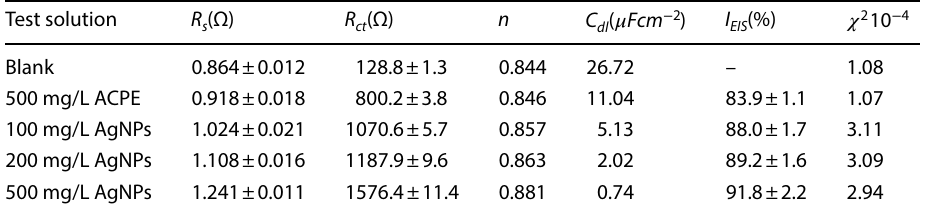
Table 2 PDP parameters for the inhibition of X80 steel corrosion in 1 M HCl containing Et-ACPE and different concentrations of its